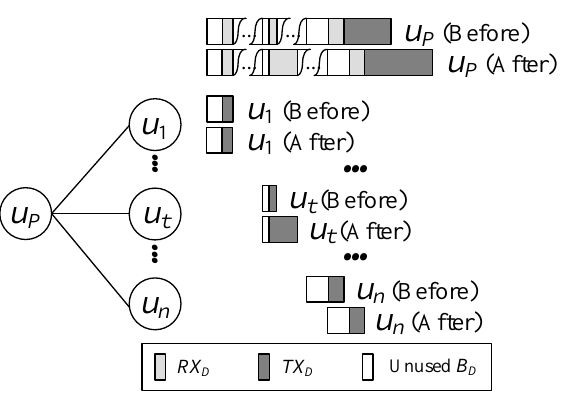
Figure 6. Schedule adjustment for data traffic